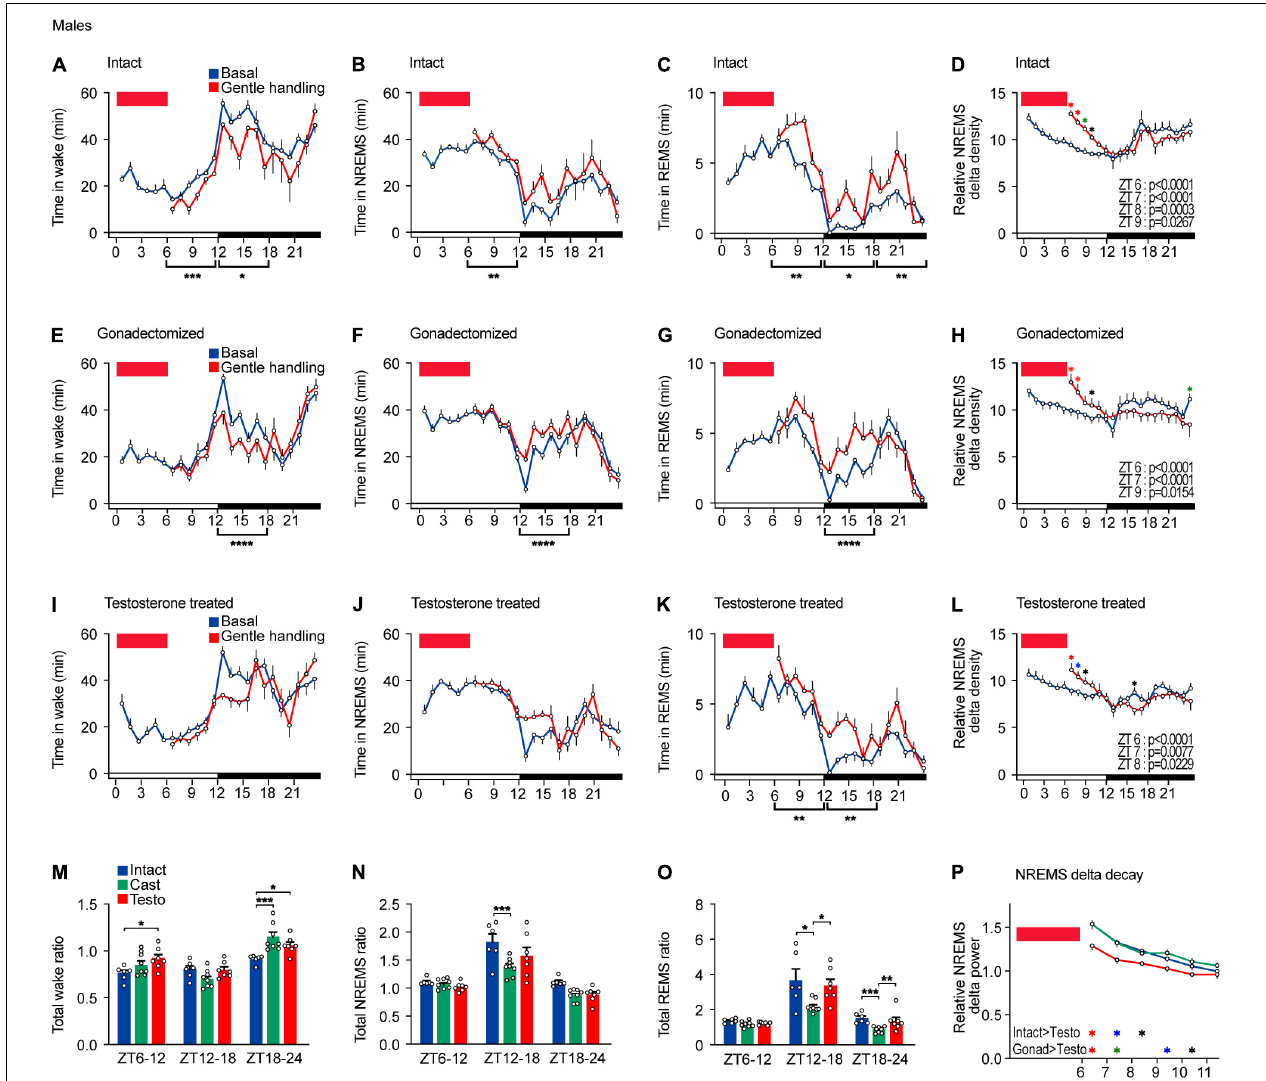
FIGURE 3 | Sleep/wake behavior of male mice after sleep deprivation by gentle handling. (A–D) Hourly wake time (A) , NREMS time (B) , REMS time (C) , and NREMS delta density (D) under the baseline condition and after 6-h sleep deprivation from ZT0 in intact male mice; six mice. Two-way ANOVA followed by Sidak’s test. (E–H) Hourly wake time (E) , NREMS time (F) , REMS time (G) , and NREMS delta density (H) under the baseline condition and after 6-h sleep deprivation from ZT0 in gonadectomized male mice; nine mice. Two-way ANOVA followed by Sidak’s test. (I–L) Hourly wake time (I) , NREMS time (J) , REMS time (K) , and NREMS delta density (L) under the baseline condition and after 6-h sleep deprivation from ZT0 in testosterone-supplemented gonadectomized male mice; seven mice. Two-way ANOVA followed by Sidak’s test. (M–O) Ratio of total awake time (M) , NREMS time (N) , and REMS (O) in 18 h to baseline condition after 6 h of sleep deprivation. Two-way ANOVA followed by Sidak’s test or Kruskal–Wallis test. (P) NREMS delta after sleep deprivation. Red rectangles in the graphs indicate gentle handling from ZT0 to 6. Two-way ANOVA followed by Sidak’s test. * P < 0.05; ** P < 0.01; *** P < 0.001. * P < 0.05 (black); * P < 0.01 (blue); * P < 0.001 (green); * P < 0.0001